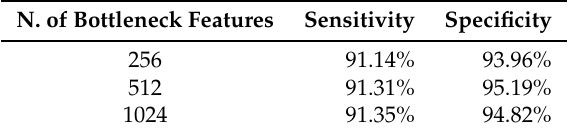
Figure 12. The altered networks run in our tests for representation power and speed. Table 3. Learning capabilities for different-sized Mini U-Nets for garbage detection.